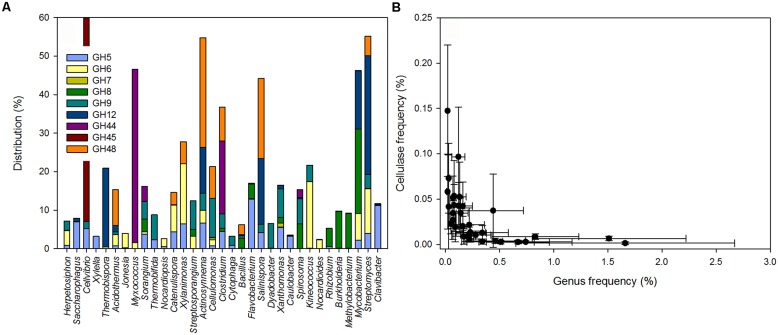
(A) Distribution of cellulolytic enzymes in potential bacterial cellulose degraders. (B) Relationship between the lineage specific cellulase frequency and the potential cellulose degrading genera in the leaf litter metagenomes (PSpearman < 0.01).